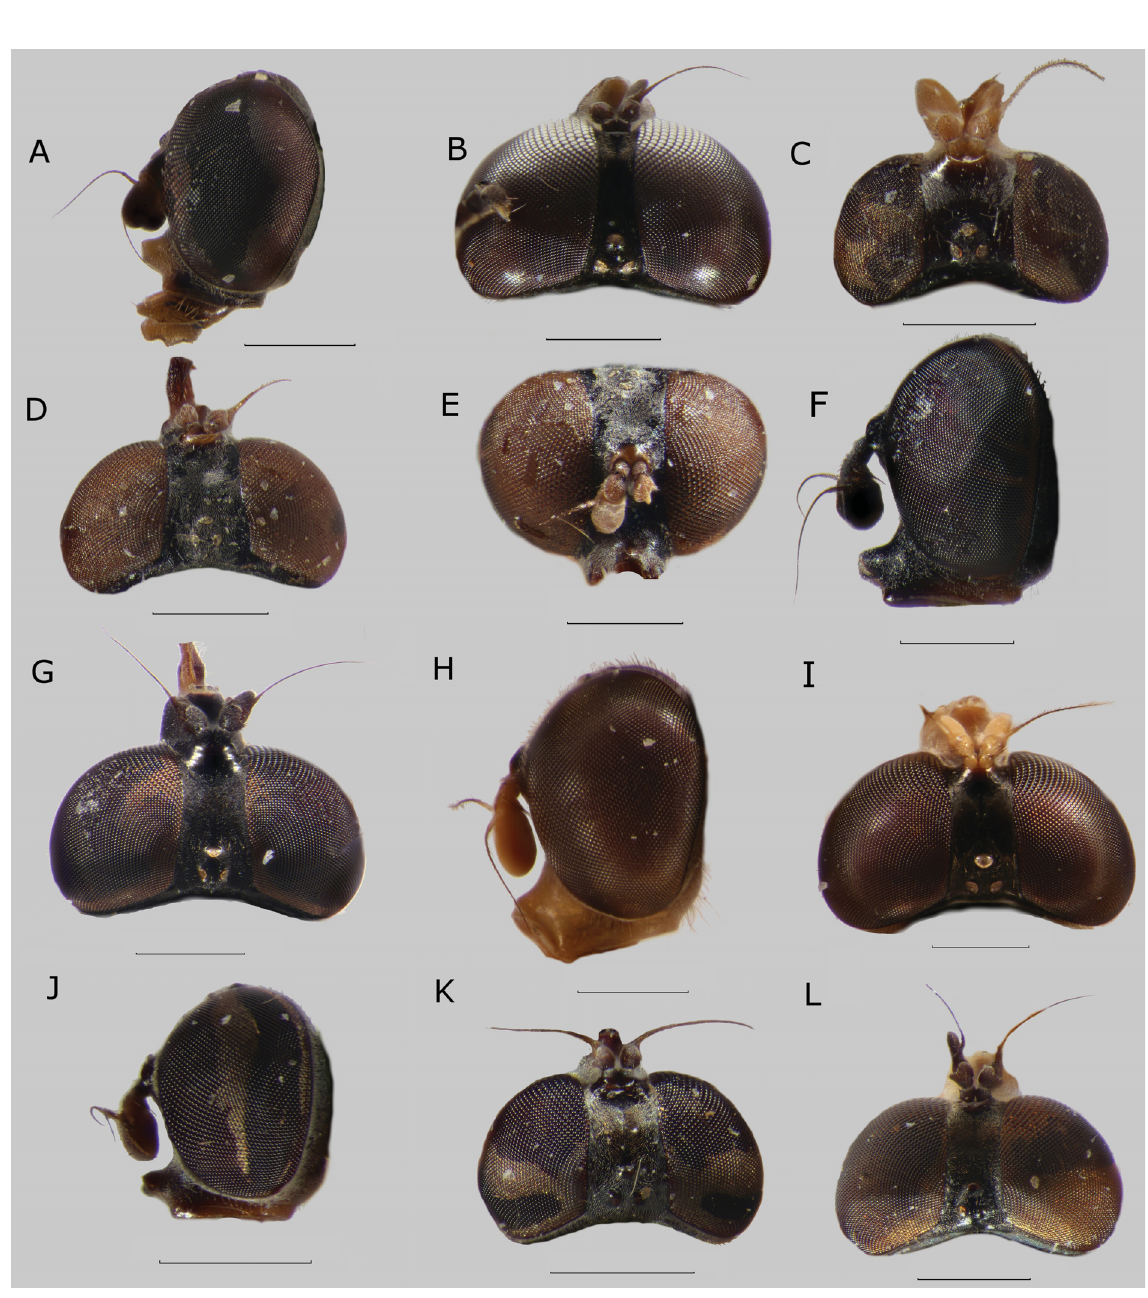
Fig. 30. Head, lateral view (A, F, H, J), dorsal view (B–D, G, I, K–L) and frontal view (E). A–B . Sp